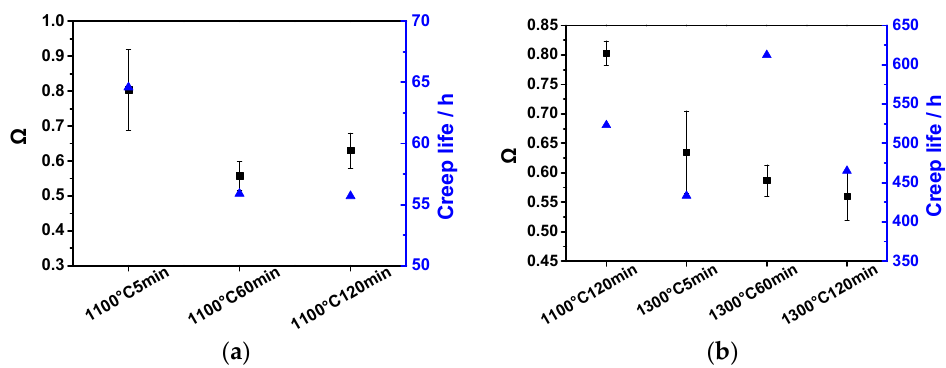
Figure 7. The integrity of γ ’ raft ( Ω ) in the dendrite core regions of the longitudinal sections of the experimental alloy and creep life under 1000 °C/300 MPa ( a ) and 1100 °C/130 MPa ( b ) after suffering overheating treatments.